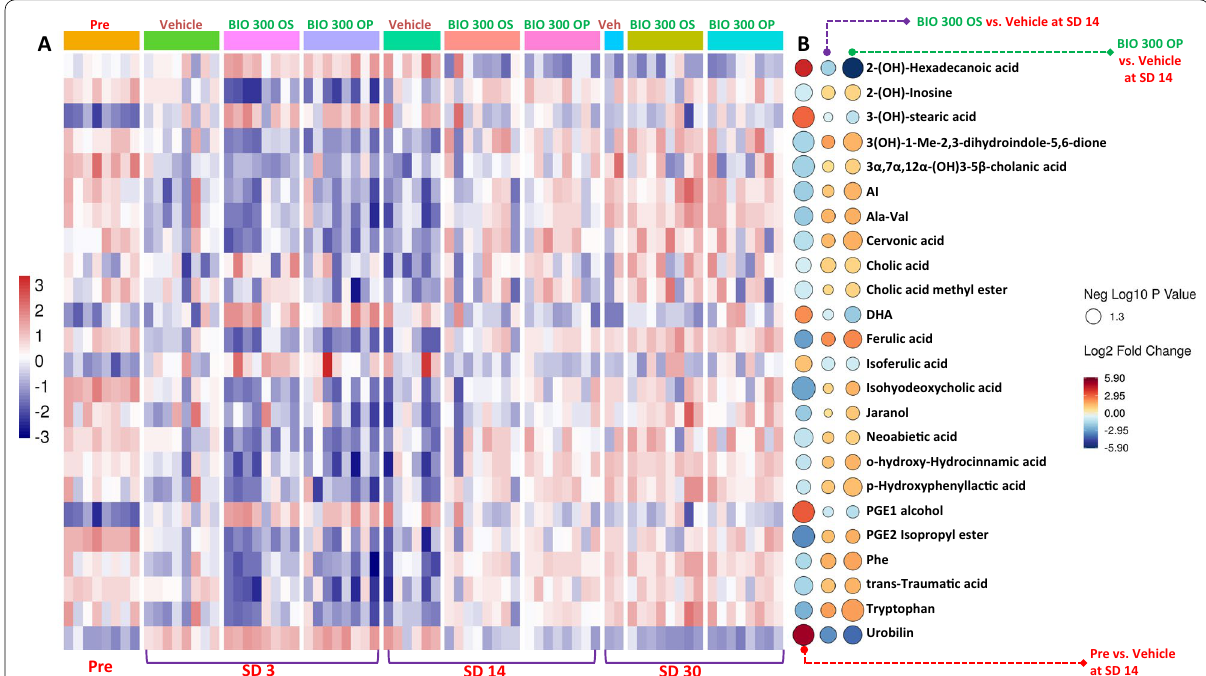
Fig. 5 Prophylactic treatment with BIO 300 restores metabolic abundance dysregulated by irradiation. Panel A Heatmap for normalized intensities of annotated metabolites. Panel B Rain plot showing the recovering effects of both formulations of BIO 300 at